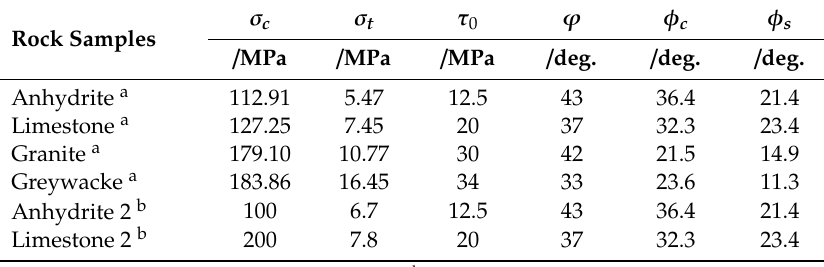
Table 2. Mechanical properties of rock samples.